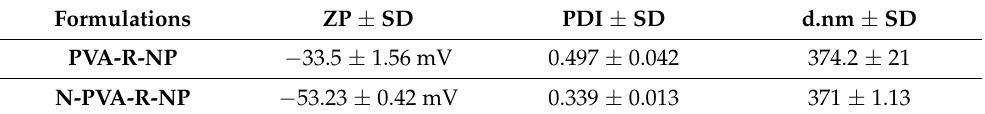
Table 1. Zeta potential, polydispersity index and mean particle size of NP formulations ( n = 3) *. Formulations